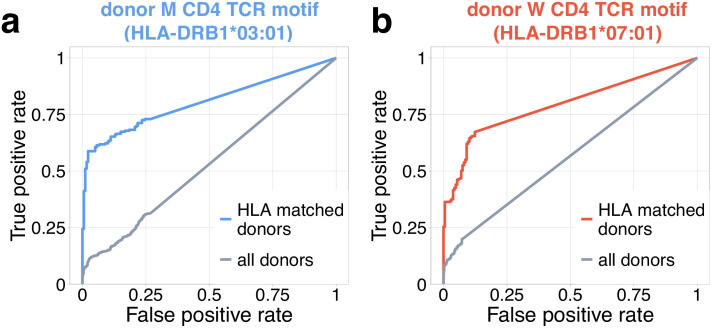
Identification of COVID-19 patients by frequency of TCR motifs from contracting CD4+ clones from donors M (a) and W (b).Receiver operating characteristic (ROC) curves for classifying TCRbeta repertoires from COVID cohort vs control by cumulative frequency of clones from CD4beta motifs. Blue curve shows ROC curve (area under the ROC or AUROC = 0.8) for the classification of control and COVID donors predicted to be DRB1*03:01-DQB1*02:01 haplotype positive with motif from donor M. Red curve shows ROC curve (AUROC = 0.79) for classification of control and COVID donors predicted to be DRB1*07:01 positive using motif from donor W. Grey ROC curves show classifier performance on all donors, irrespective of HLA allele matching (AUROC = 0.53 for (a) and AUROC = 0.57 for (b)).